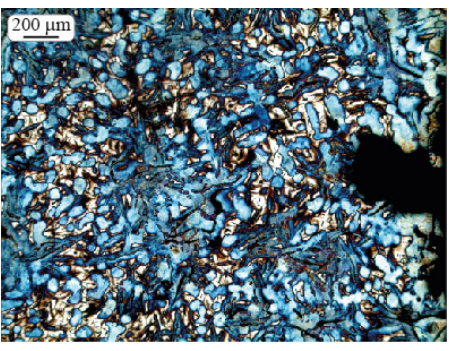
Figure 5. Micrograph representing a local solidification time of t sol = 377 s, D hyd secondary dendrite arm spacing (SDAS) = 51.45 μ m. Primary austenite appears in dendritic shape with whitish light blue color.